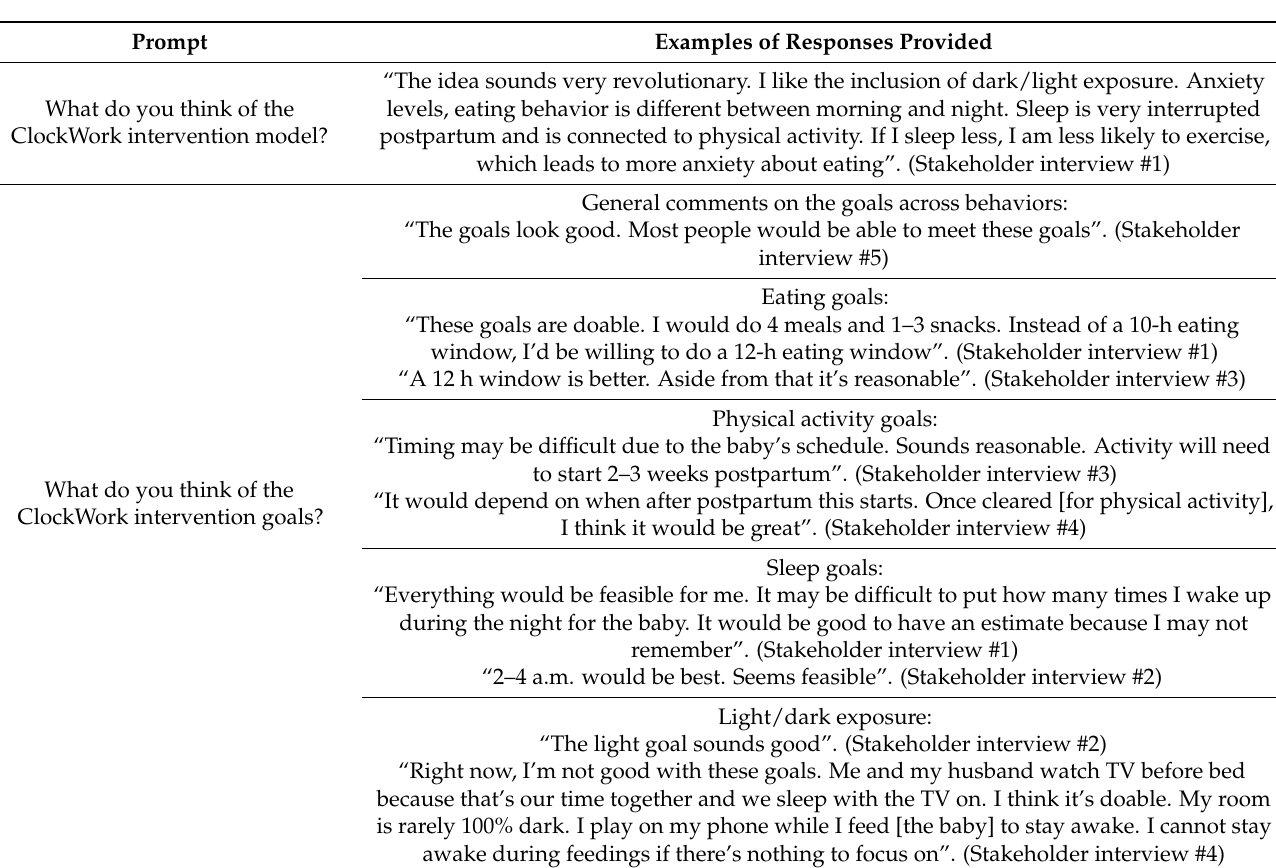
Figure 3. Screenshot of the ClockWork amount, regularity, and timing (ART) goals presented to participants for discussion in stakeholder interviews. Table 2. Examples of qualitative feedback on the ClockWork intervention model and digital monitor- ing tools from postpartum individuals who began pregnancy with a BMI ≥ 25 ( n = 5 stakeholder interviews with n = 7